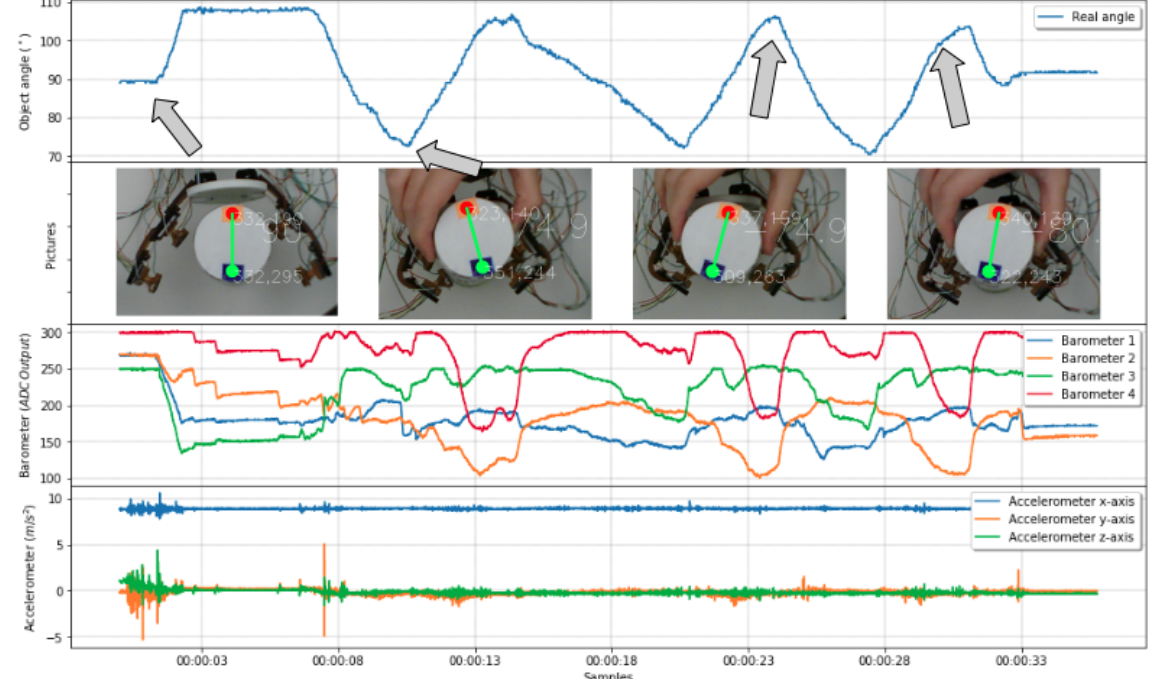
Figure 15. Object being rotated with sensors varying in accordance with the